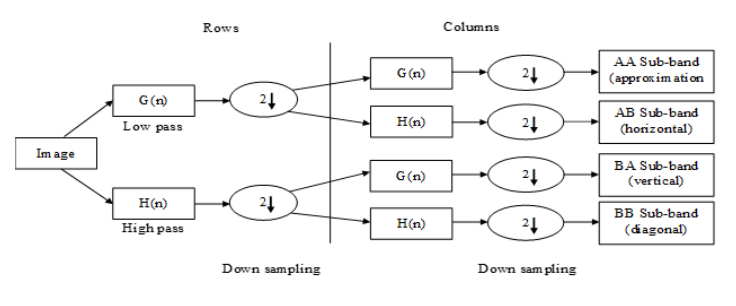
Figure 1. Filter bank approach of 2D-DWT for MR image synthesis.